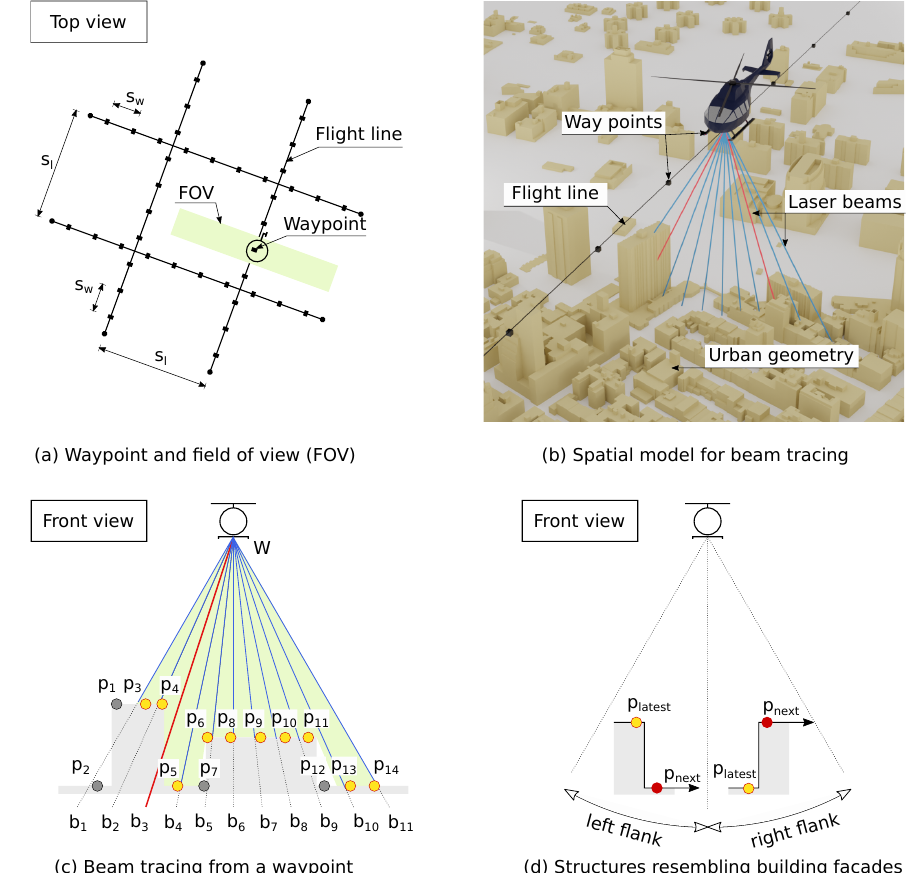
Figure 4. Laser beam tracing for estimation of missing vertical points. Red beams denote ones that strike a vertical surface and blue beams denote beams that strike in the vicinity of a base point on a non-vertical